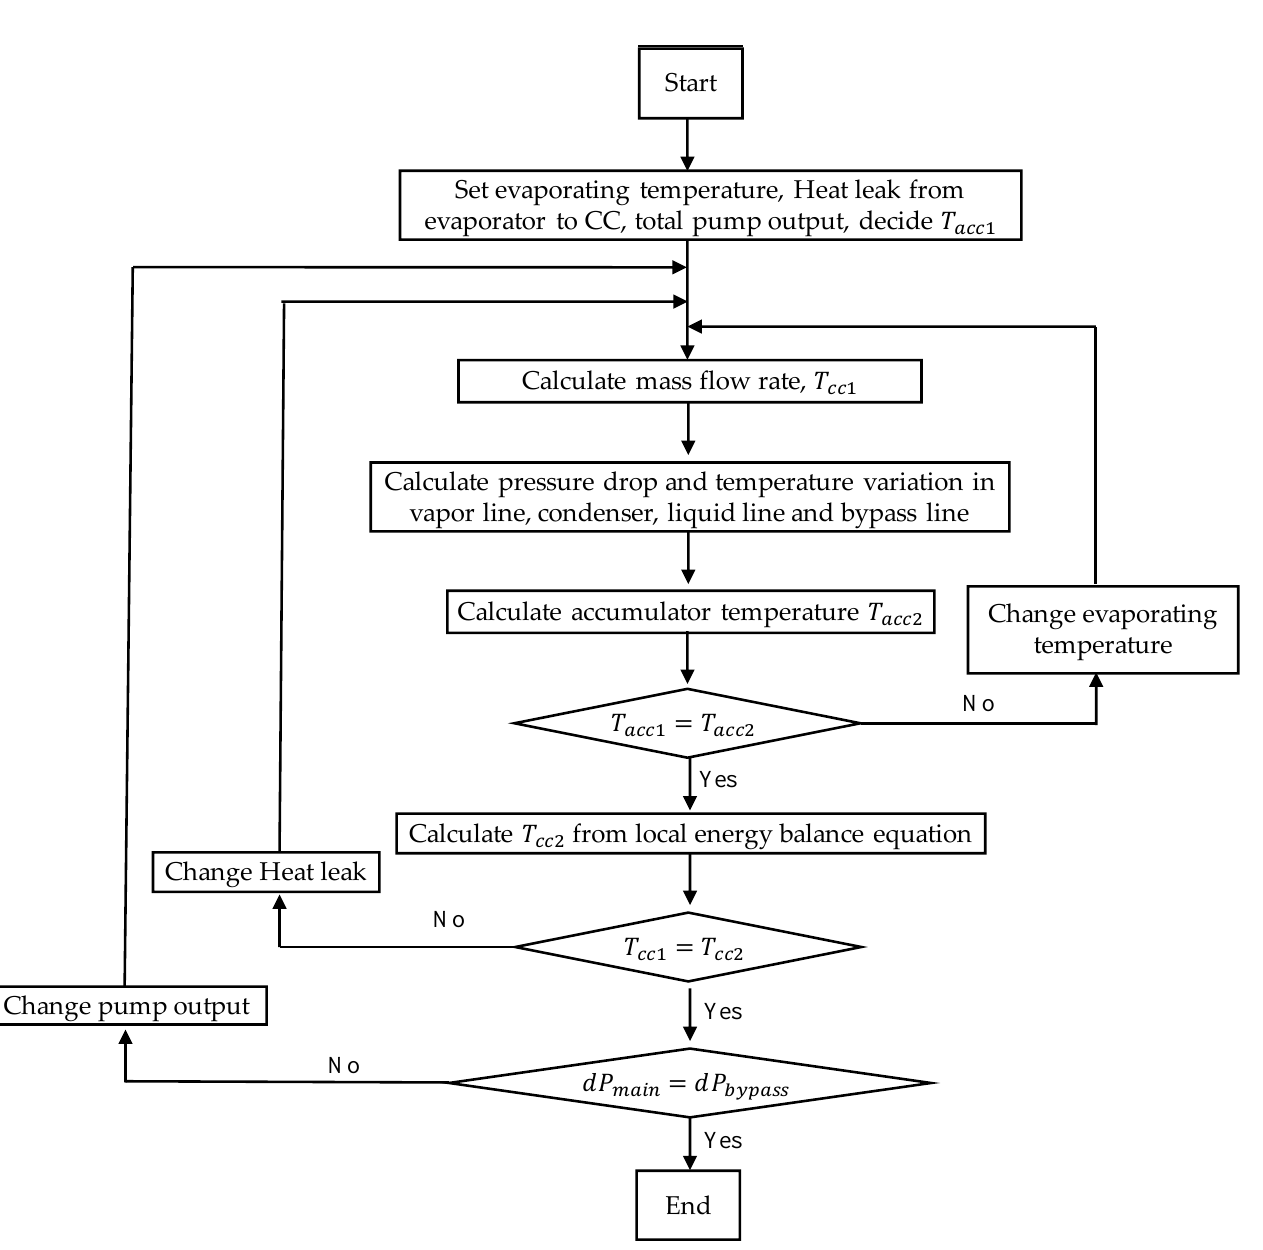
Figure 2. Flow chart of control system operation.